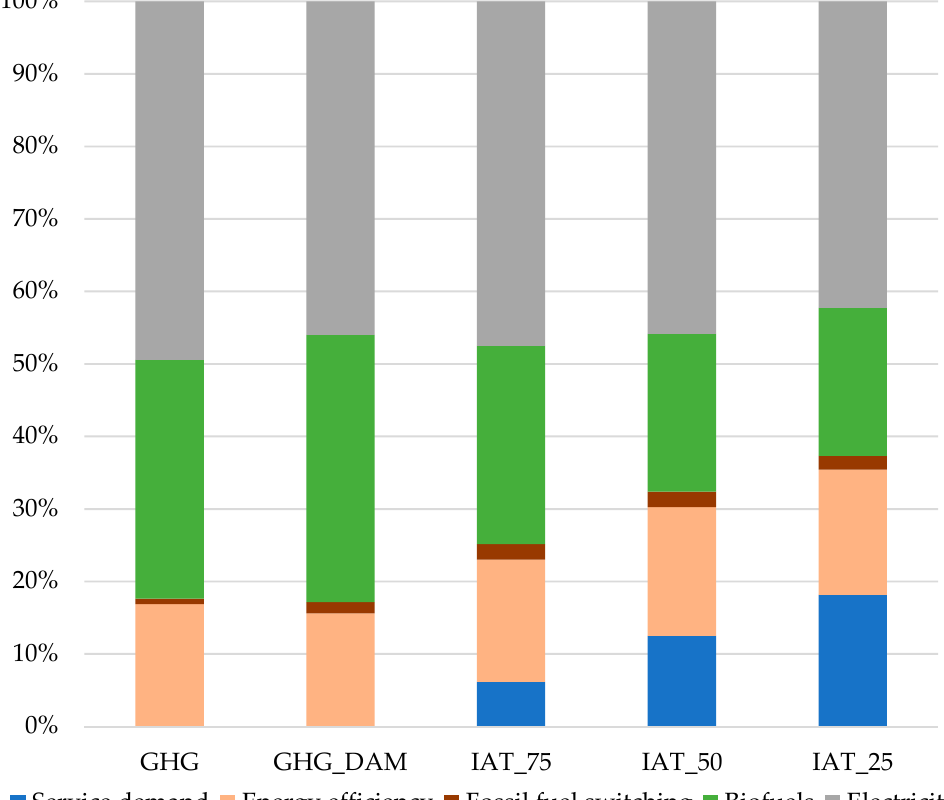
Figure 15. Shares of different mitigation options in CO 2 decomposition analysis in different scenarios in the EU28 in 2050—transport sector.